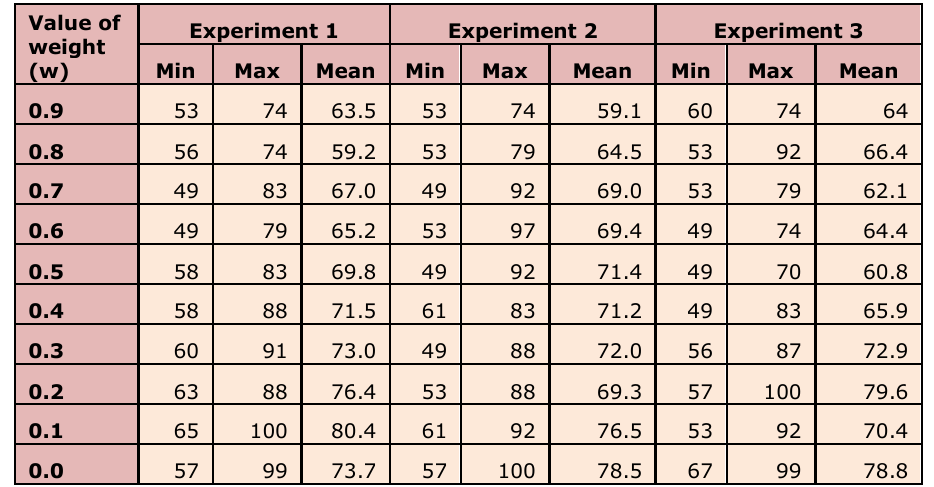
Table 5. Minimum, Maximum and Mean value of cost of crashing generated in experiments consisting of 10